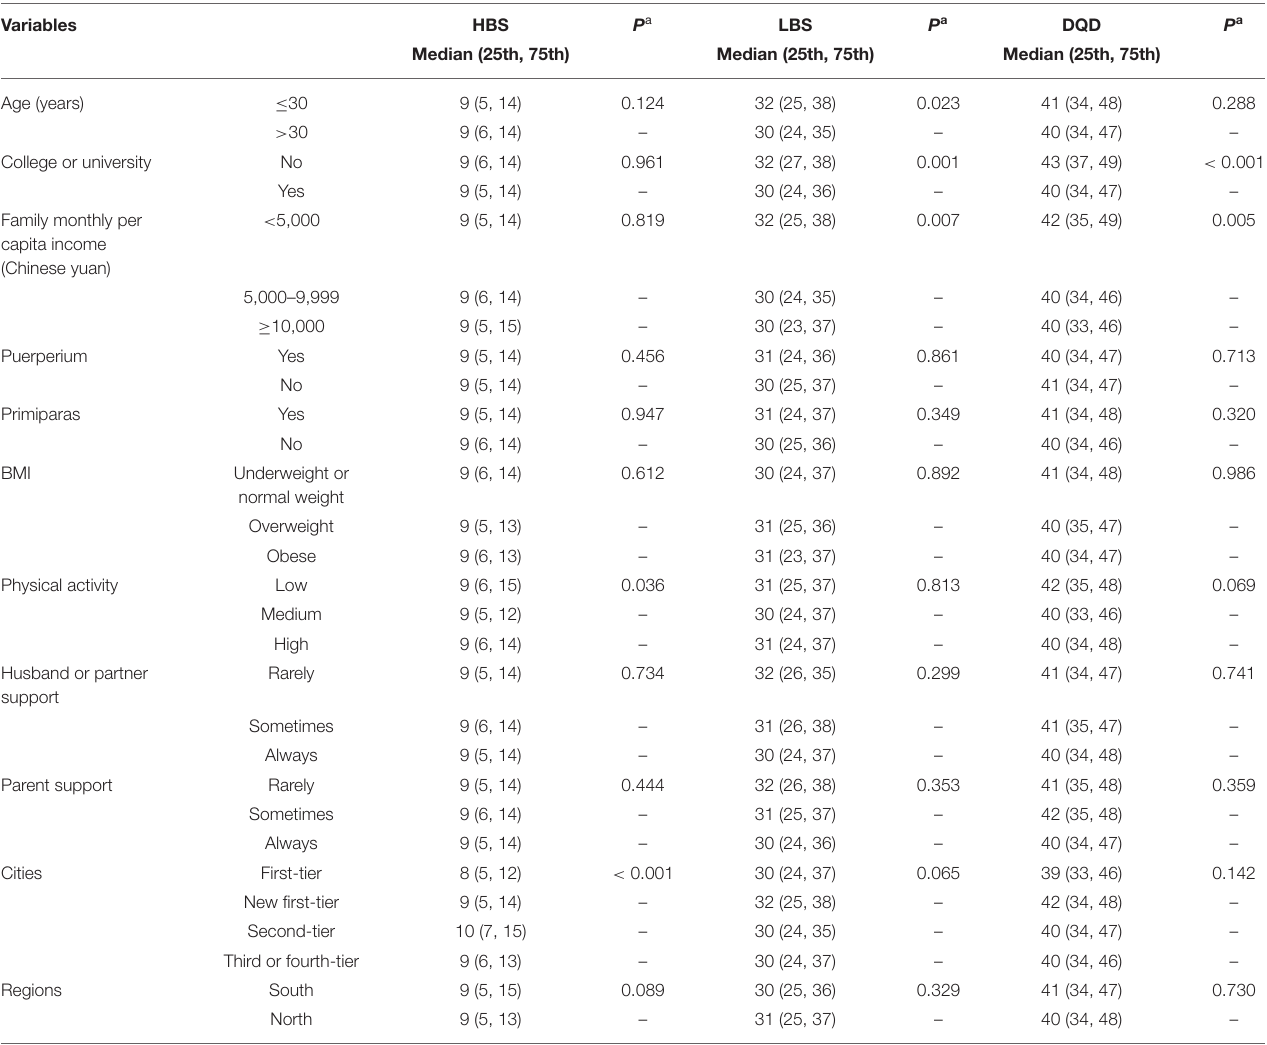
TABLE 2 | Comparison of HBS, LBS, and DQD [Median (25th, 75th)] by different characteristics of lactating